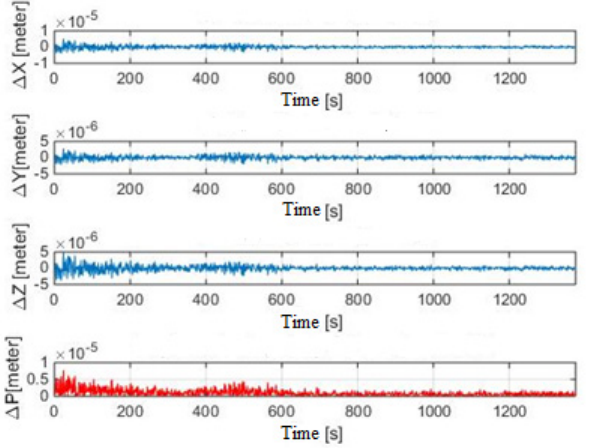
Figure 6. Coordinate determination errors ∆ X, ∆ Y, ∆ Z and position ∆ P, flight with the maneuver.